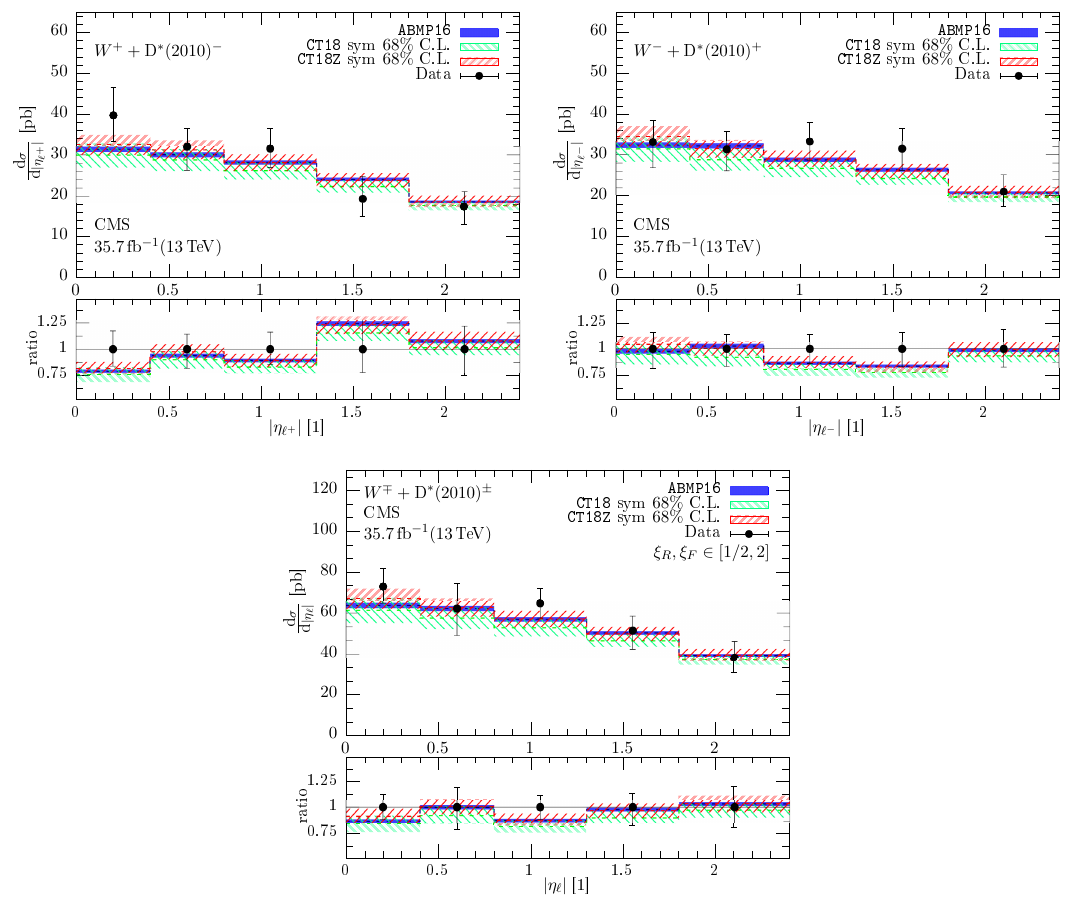
Figure 8 . Same as figure 3, but using the three different NLO PDF + α S ( M Z ) sets ABMP16_3_NLO, CT18ZNLO and CT18NLO, each one with its own uncertainties. A value of m c = 1 . 5 GeV is used in association with the ABMP16_3_NLO fit, whereas m c = 1 . 4 GeV is used in association with the CT18ZNLO and the CT18NLO fits. Differently from figure 6 and 7, the CT18NLO and CT18ZNLO uncertainty bands in this figure are symmetrized by computing them with the specific prescription provided by the CT collaboration and scaled to the 68% C.L. to facilitate a more direct comparison with the ABMP16 uncertainty bands, symmetric by fit con- struction, customarily provided at this C.L. corresponding to the tolerance criterion adopted in the ABMP16